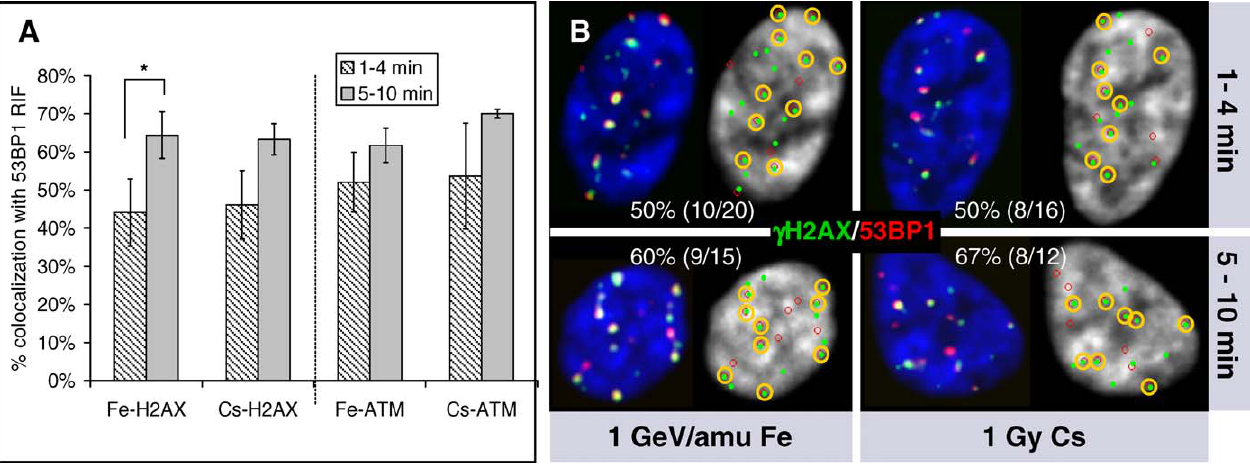
Figure 9. Increased Co-Localization of DNA Damage Markers Rapidly after Exposure to Radiation (A) is an analysis summary of c H2AX and ATMp co-localization with 53BP1 done in 3-D. Two RIFs are considered co-localized if the distance between their centers is less than or equal to 0.48 l m. As described in Materials and Methods, RIF centers are determined as the brightest pixel within each spot. The c H2AX co-localization is illustrated in (B) with representative images of different time points and different type of radiations. c H2AX and 53BP1 foci locations are shown as green disks and red circles, respectively. Co-localized centers are circled by a yellow contour on the image, and the amount of c H2AX co-localization is reported for each image. Both exposure to c -rays (Cs) and 1 GeV/amu Fe are illustrated for the two different time periods considered after exposure to radiation (1–4 min and 5–10 min). Averages for Cs are based on two independent experiments, whereas averages for Fe are based on four independent experiments. A t -test was performed, and a p -value of 0.01 was computed between the first and second time period considered for c H2AX (statistical significance noted on the graph as